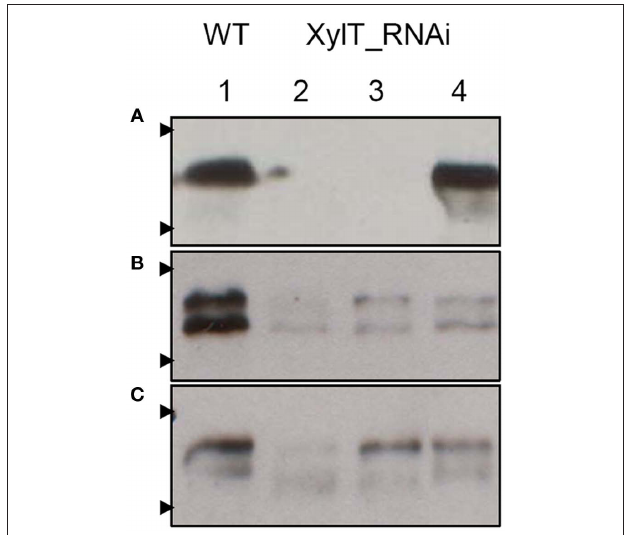
FiguRe 6 | ige-binding and allergenic potency of XylT_RNAi tomato fruits. Investigation of IgE-binding to soluble protein extracts from red fruits of L. esculentum cv. MicroTom wild type (WT, lane 1), XylT_RNAi line 3 (lane 2), XylT_RNAi 12 (lane 3), and XylT_RNAi 6 (lane 4). Proteins were separated on 12.5% SDS-PAGE, blotted to nylon membranes and probed with sera from tomato allergic patient T 039 (A) , T 018 (B) , and T 029 (C) . Arrow heads indicate protein standards of 55 and 36 kDa, respectively.